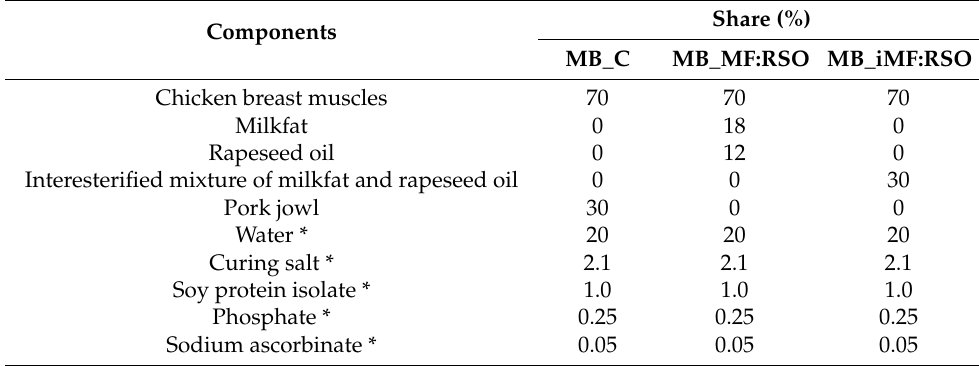
Table 1. Composition of